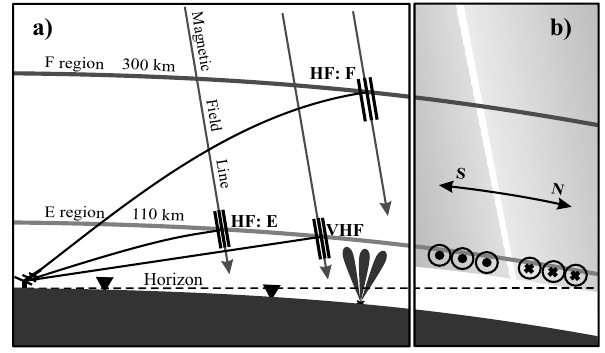
Fig. 2. The schematic diagram showing (a) the geometry of ob- servations along a meridian (north is to the right) in the vertical plane and (b) electrojet current system near the boundary dividing the eastward (circles with dots) and westward (circles with crosses)